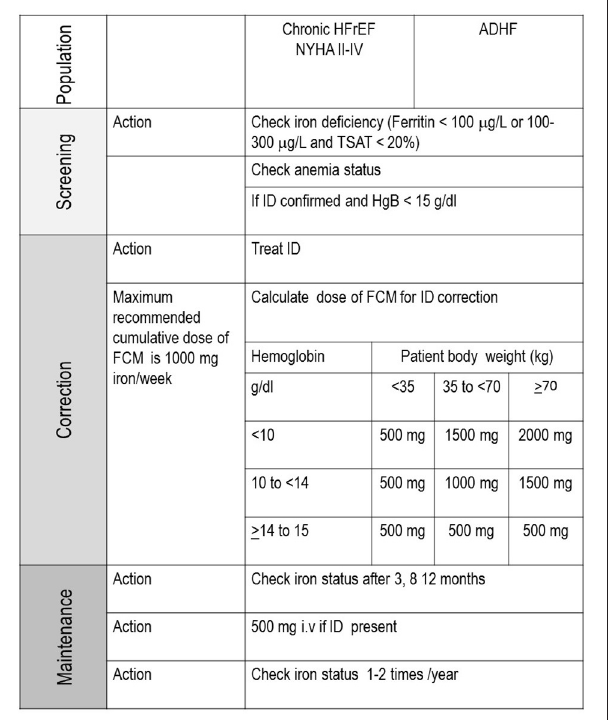
FIGURE 2 | Algorithm for diagnosis and treatment of